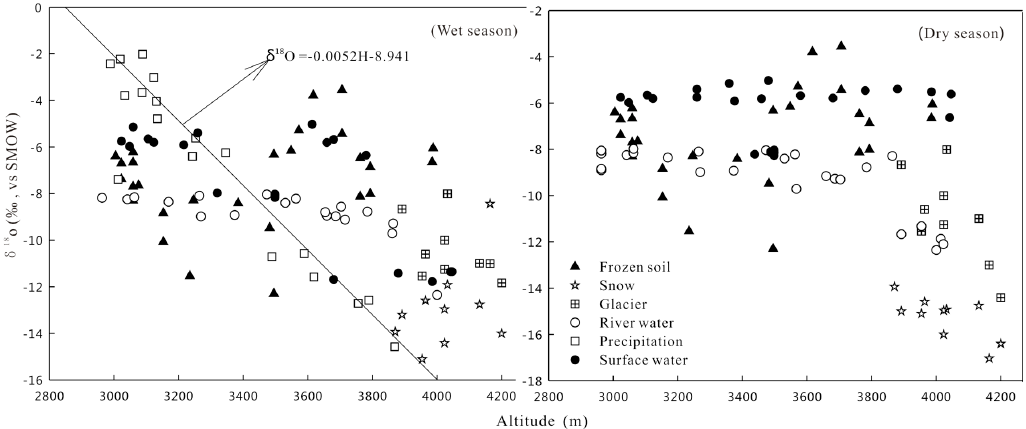
Figure 2. Altitude effects of oxygen δ 18 O for various waterbodies in different landscape zones in the wet and dry season. wet and dry